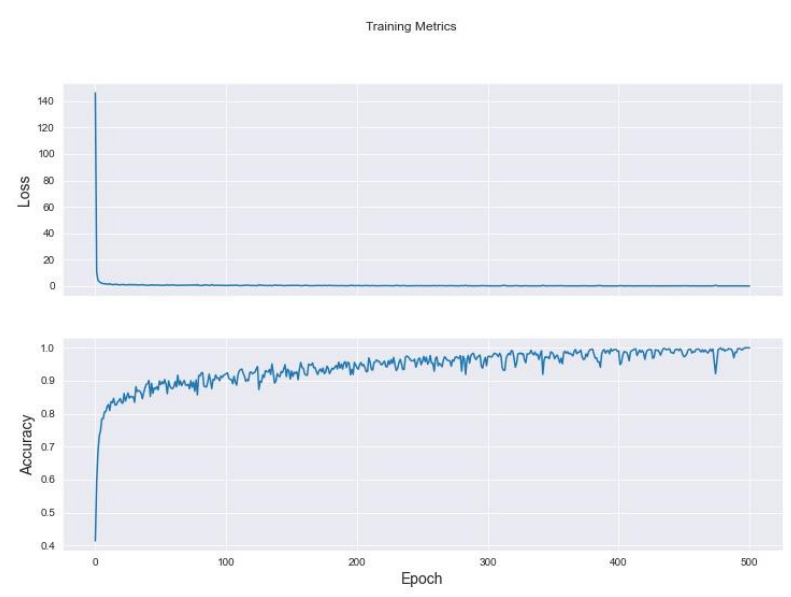
Figure 5. DBN training accuracy and loss curve.